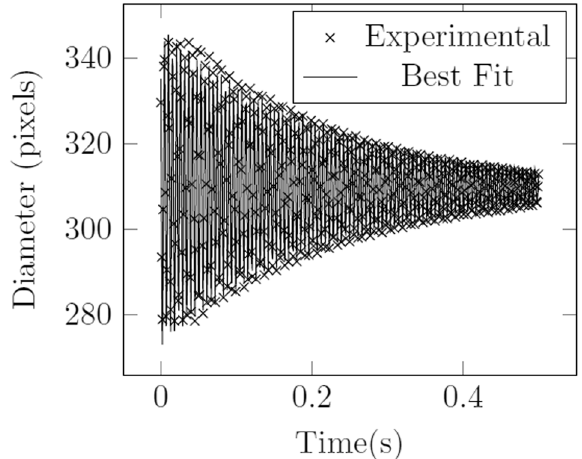
Fig. 2 A typical set of data from the pulse decay technique and its fi t to an exponentially decaying sinuosoidal function. Sample is 35.027 mg Zirconium at 1800 ∘ C. cf 15